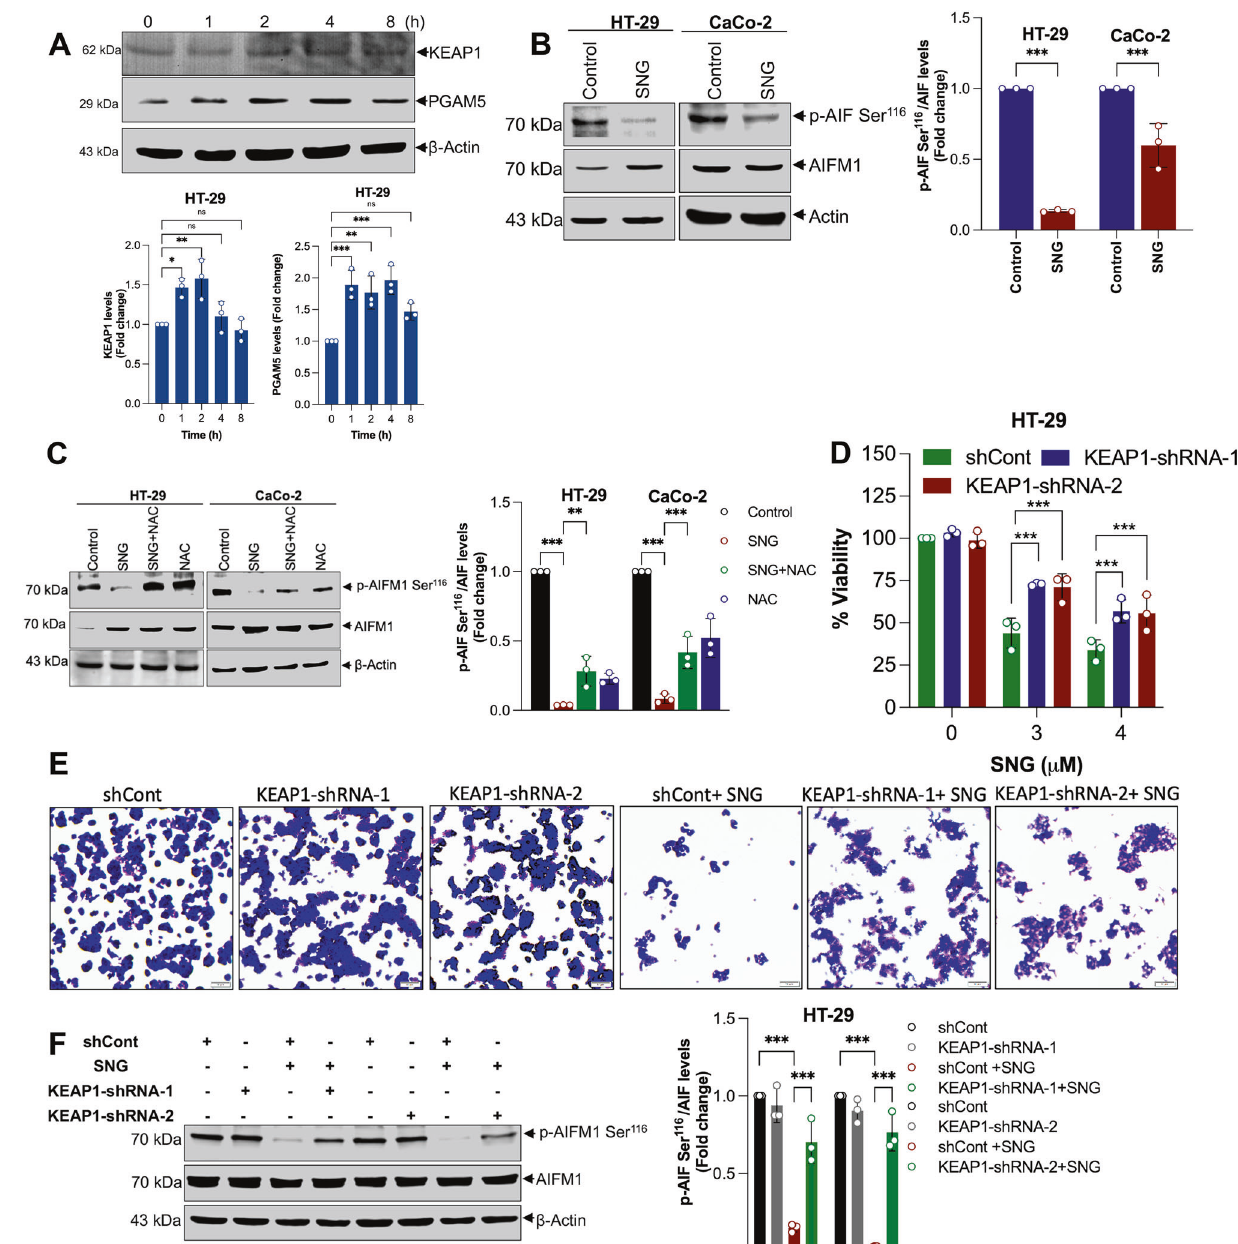
Fig. 5 Activation of KEAP1-PGAM5-AIFM1 signaling axis in SNG-induced oxeiptosis. A HT-29 cells were treated with SNG for indicated time and Western blot analysis was carried out. The signal intensities of western blot bands were normalized to actin of each group, and fold changes were plotted in a histogram from three independent experiments. Signi fi cant difference, * p < 0.05, ** p < 0.01, *** p < 0.001 and ns = no signi fi cance. B HT-29 and CaCo-2 cells were treated with SNG for 16 h and 6 h, respectively. Following the treatment, Western blot analysis of indicated proteins was performed. The signal intensities of western blot bands were normalized to AIFM1 of each group, and fold changes were plotted in a histogram from three independent experiments. Signi fi cant difference, *** p < 0.001. C Cells were treated with SNG in the presence or absence of NAC, and Western blot analysis of indicated proteins was performed. The signal intensities of western blot bands were normalized to AIFM1 of each group, and fold changes were plotted in a histogram from three independent experiments. Signi fi cant difference, ** p < 0.01 and *** p < 0.001. KEAP1-shRNAs-transfected HT-29 cells were treated with the indicated concentrations of SNG for 16 h. Following the treatment, D cell viability was performed by MTT assay. Data shown are mean ± SD ( n = 3) (*** p < 0.001), E crystal violet staining, Scale bar: 10 µm, and F Western blot analysis of indicated proteins was performed. The signal intensities of western blot bands were normalized to AIFM1 of each group, and fold changes were plotted in a histogram from three independent experiments. Signi fi cant difference, *** p < 0.001.